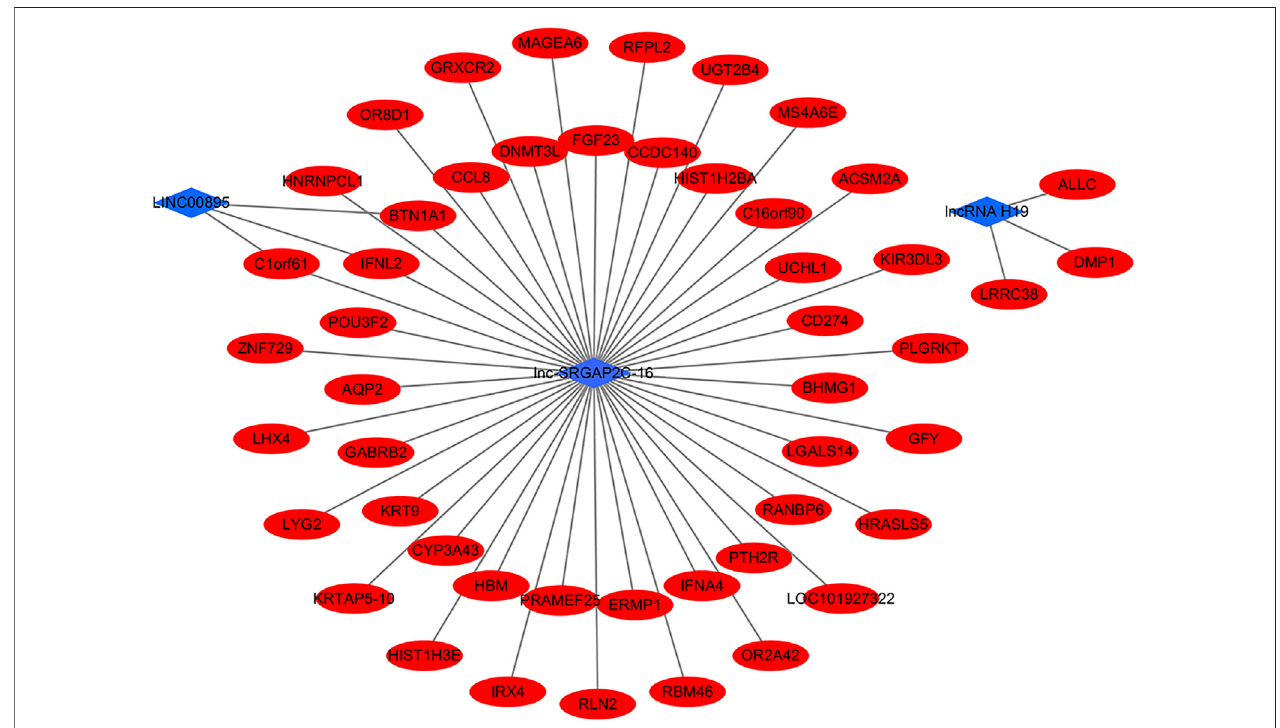
FIGURE 3 | The interaction networks of differentially expressed lncRNAs (lncRNA H19, LINC00895, lnc-SRGAP2C-16) and target mRNAs.